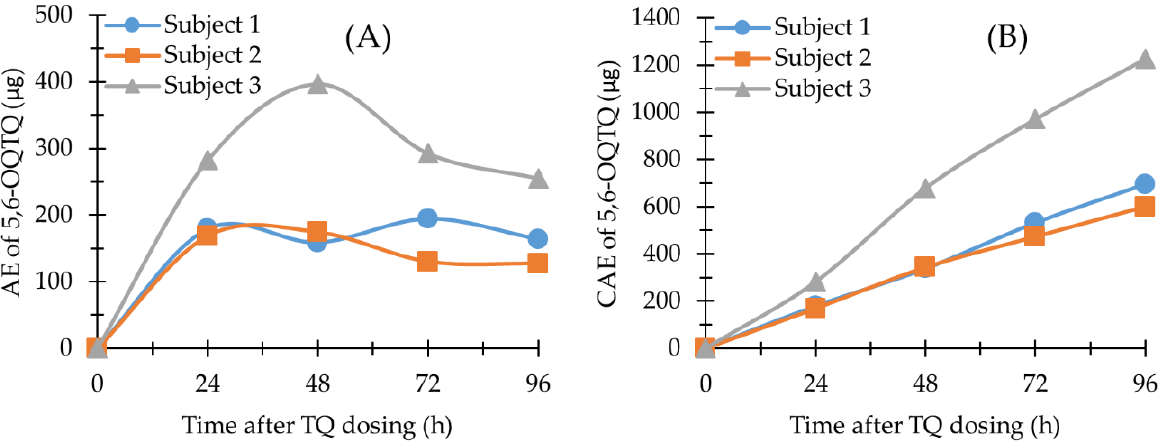
Figure 5. 5,6-OQTQ in human urine ( n = 3). ( A ) AE versus time profile; ( B ) CAE versus time profile. Time was the endpoint of each 24 h urinary collection period.